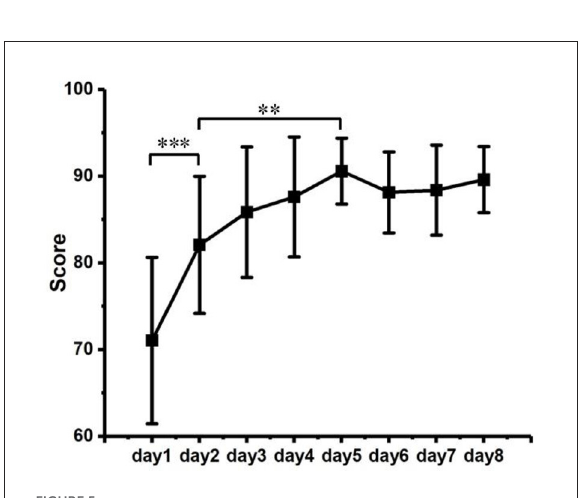
FIGURE5 Scores of behavior performance across training duration. Significant level: ** as p < 0.01 and *** as p <